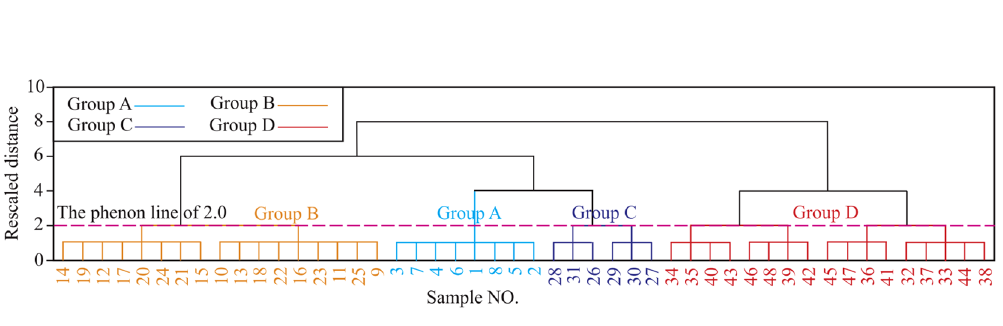
Figure 9. Dendrogram of HCA